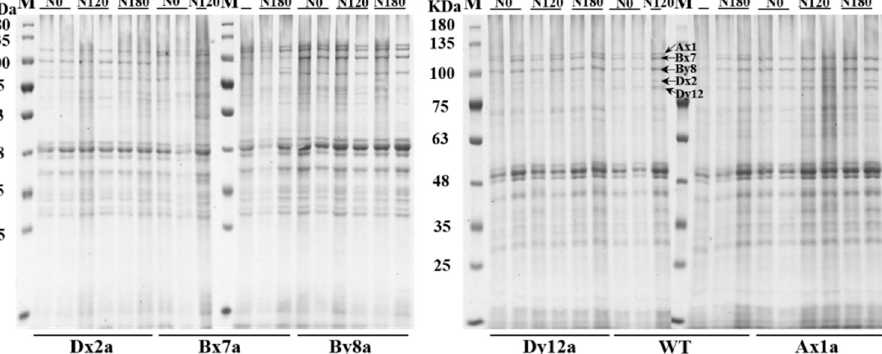
Figure 2. SDS-PAGE patterns of proteins in flour of wheat lines with the absence of HMW-GS under different N treatments.